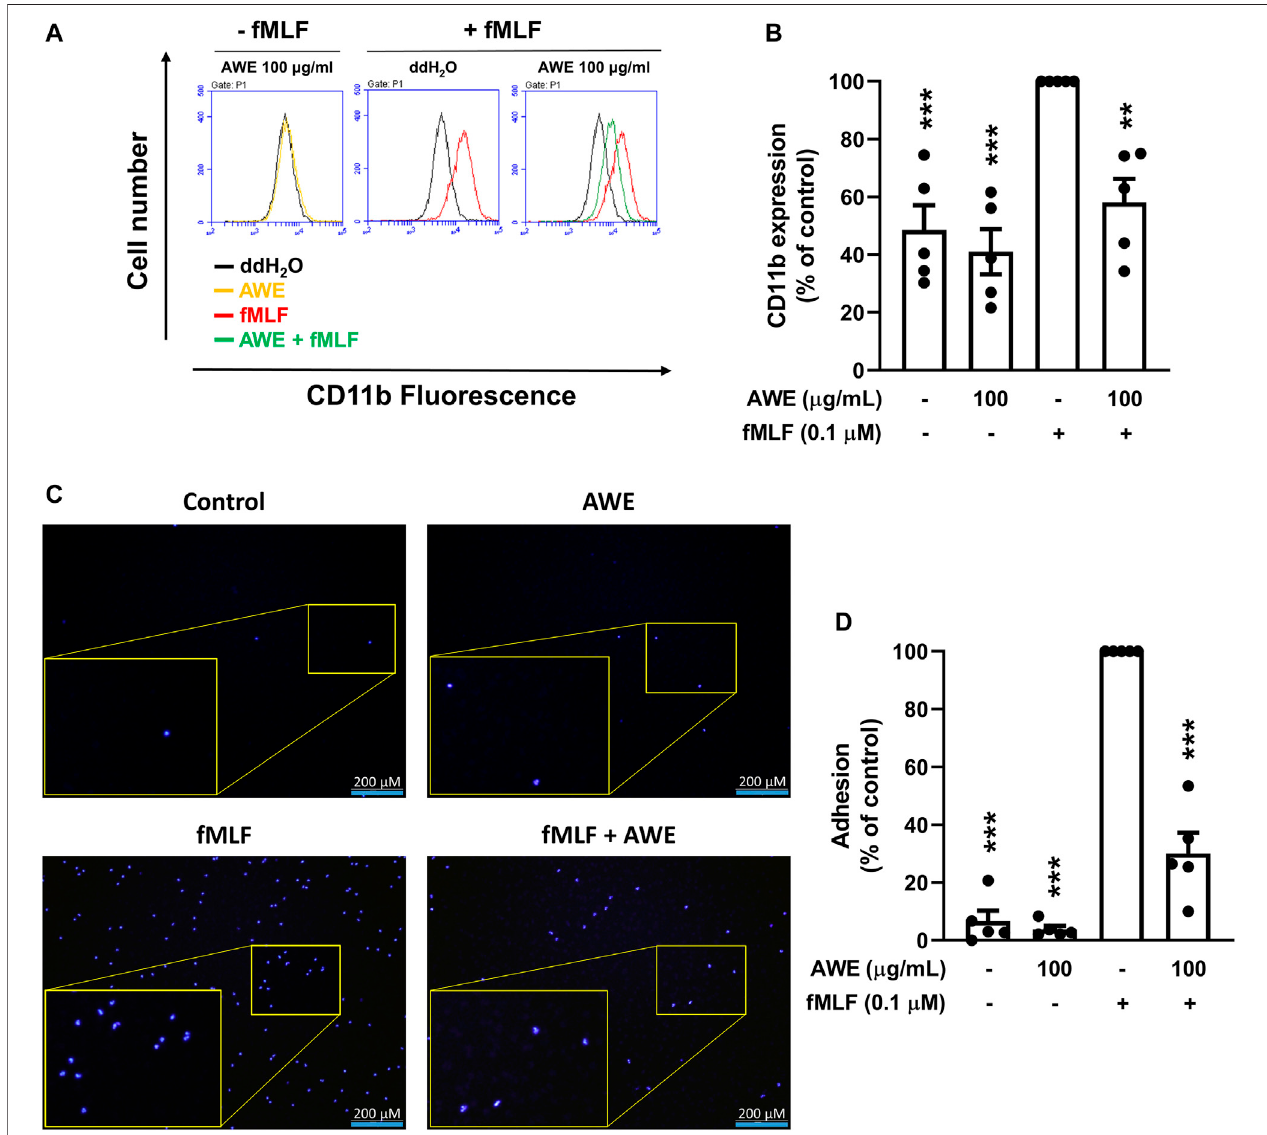
FIGURE 7 | AWE suppressed the adhesion of fMLF-activated human neutrophils to bEnd.3 cells by inhibiting CD11b expression. (A) Human neutrophils were incubated with ddH 2 O (as the control) or AWE (100 μ g/ml) for 5 min and then activated by fMLF (0.1 μ M)/CB (1 μ g/ml) for an additional 5 min. Representative histograms demonstrating typical fl uorescence in the absence or presence of FITC-labeled anti-CD11b. (B) Mean fl uorescence intensities are shown. (C) Hoechst 33342-labeled human neutrophils (4 × 10 6 cells/mL) were incubated with ddH 2 O or AWE (100 μ g/ml) for 5 min, then fMLF (0.1 μ M) was used as the stimulant. The activated human neutrophils were added into bEnd.3 cells for 15 min. Adherent neutrophils on bEnd.3 cells were detected using a fl uorescence microscope. Scale bar represented 200 μ m. Representative histograms for fl uorescent microscopy are shown. (D) Adherent human neutrophils were counted and quanti fi ed. Data are expressed as the mean ± S.E.M. ( n (cid:2) 5). Statistical analysis was conducted using the one-way analysis of variance (ANOVA), followed by Tukey ’ s multiple comparison test if there were statistical differences in the results of ANOVA. Adjusted p -values of Tukey ’ s multiple comparison tests were de fi ned as *** p < 0.001 and ** p < 0.01 compared with the